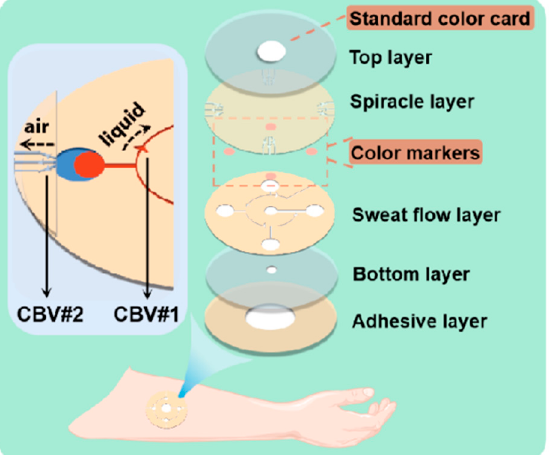
Figure 1. Enlarged view of microfluidic patch with capillary bursting valves (CBVs).